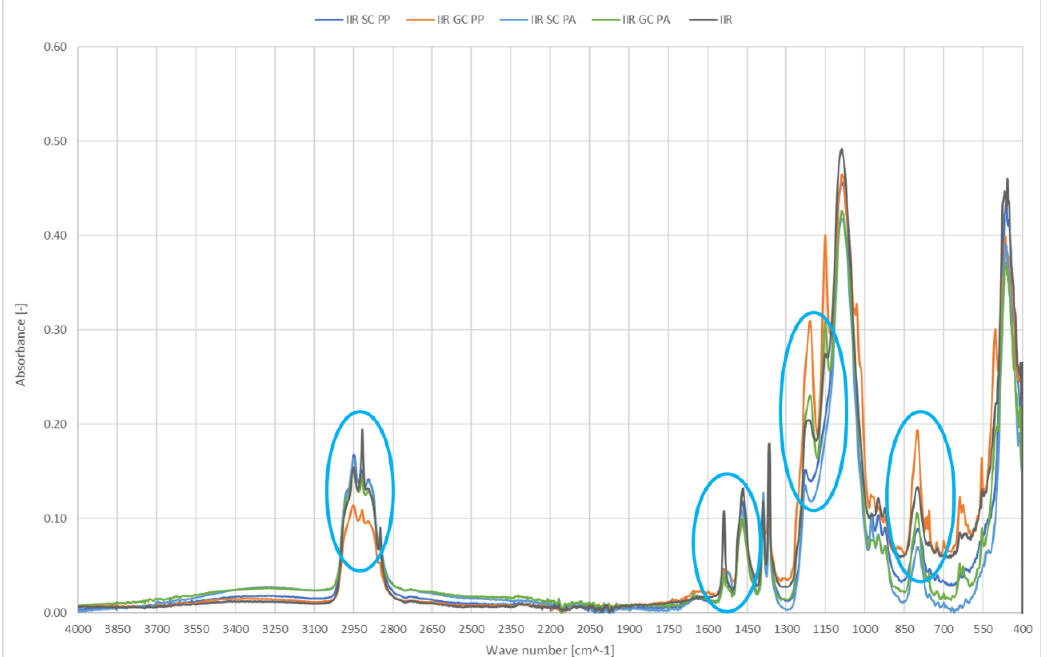
Figure 6. IR spectra of polymer materials made of butyl rubber (SC — chemically modified smooth samples, GC — chemically modified geometrised samples subjected to plasma modification in the air (PP) or argon (PA), and for non-modified polymer material made of butyl rubber).